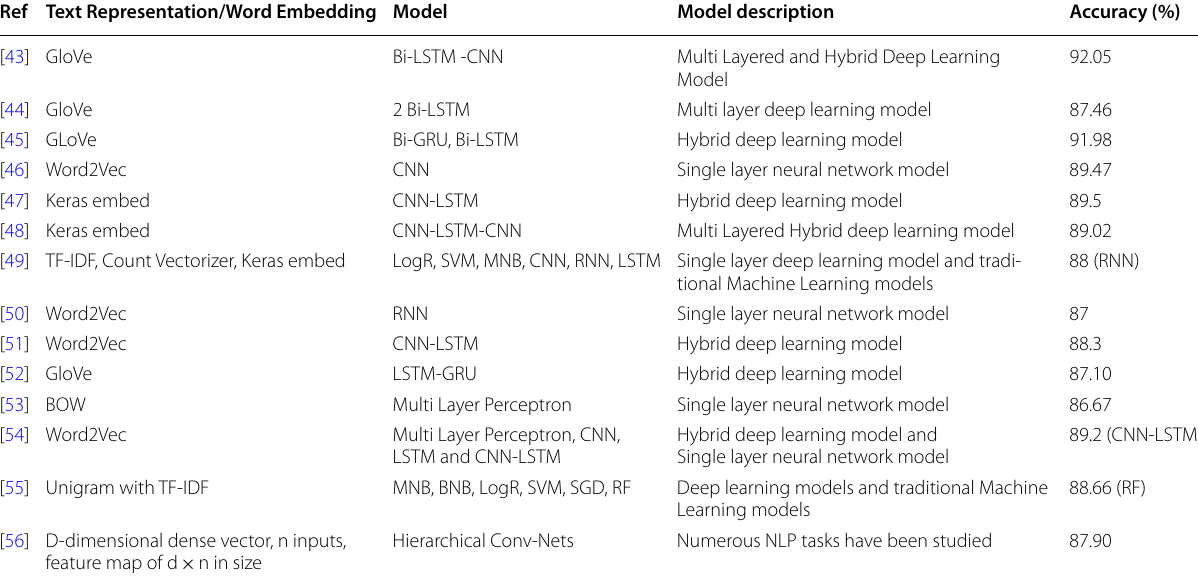
Table 1 Sentiment analysis studies on the IMDB dataset Ref Text Representation/Word Embedding Model